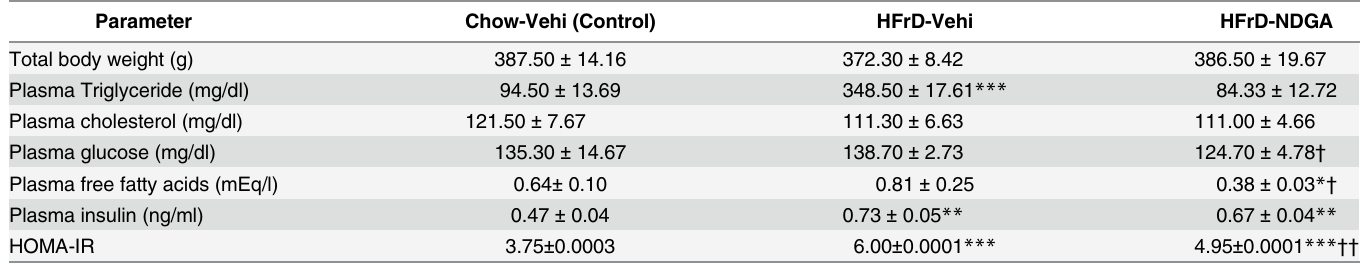
Table 2. Body weight and Plasma glucose, insulin and lipid profiles in Sprague Dawley rats fed a chow diet (n = 4), a high-fructose diet (HFrD, n = 6) or a HFrD and treated with NDGA (n = 6).